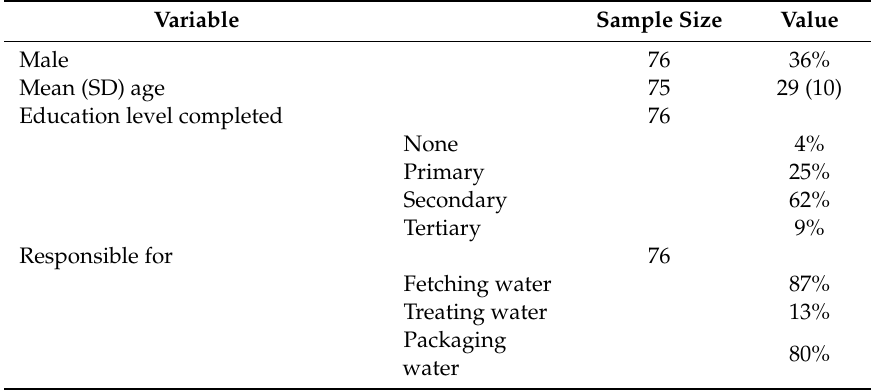
Table 2. Summary of water vendor